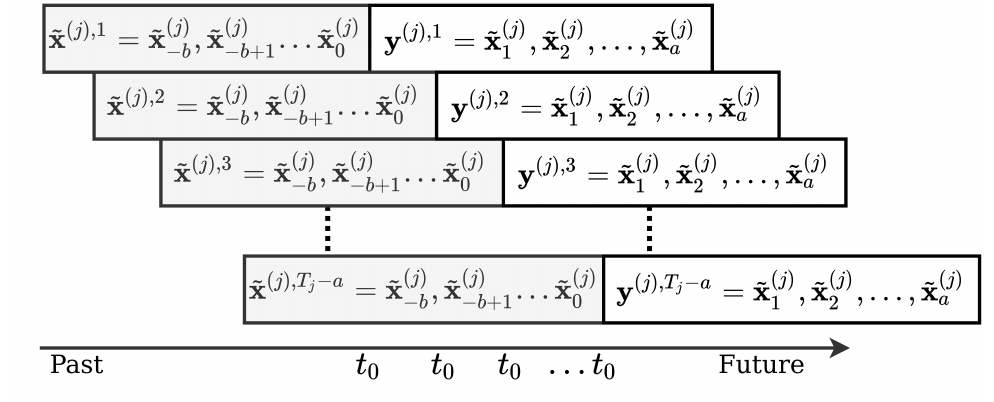
Figure 1. Generating samples and targets from Automatic Identification System (AIS) data using the sliding window approach here shown for a single sub-trajectory, ˜ x ( j ) of length T j . Samples, ˜ x ( j ) ,1 . . . ˜ x ( j ) , T j − a , of size b x f and targets of size a x f are made. With the sliding window approach, time t 0 shifts with the